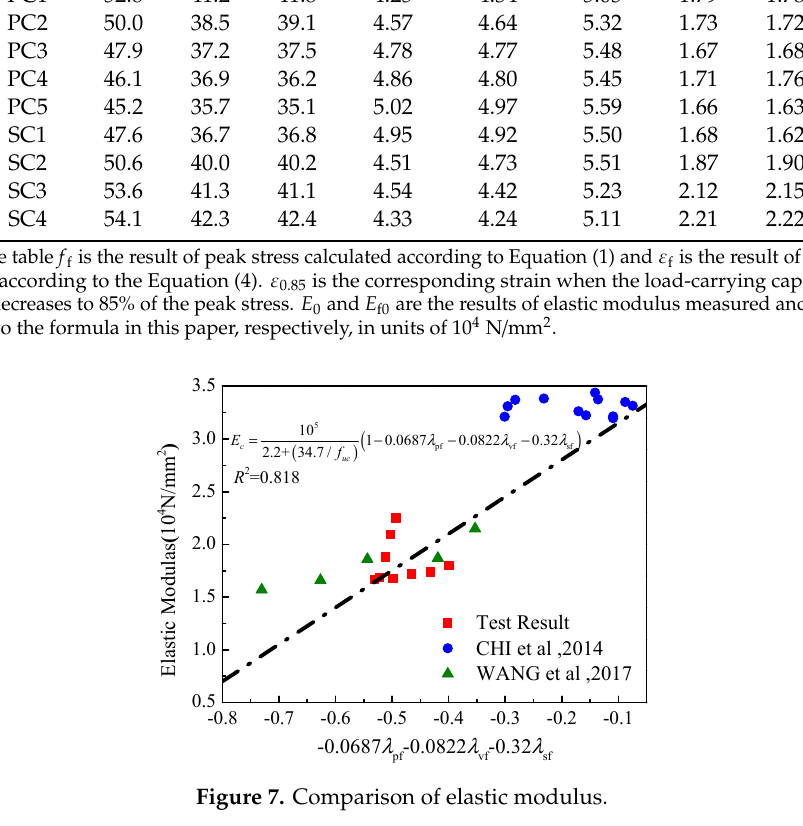
Figure 7. Comparison of elastic modulus.